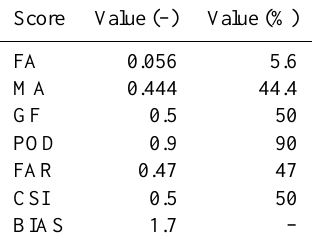
Table 5. Score values for basins with area ≤ 150km 2 . FA are the false alarms, MA are the missed alarms, GF are the good